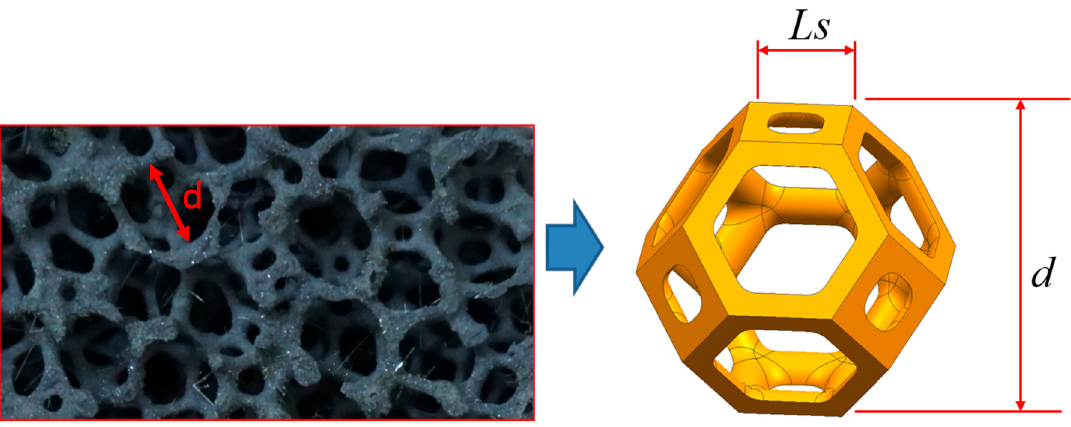
Figure 4. Geometric model used for simulation.